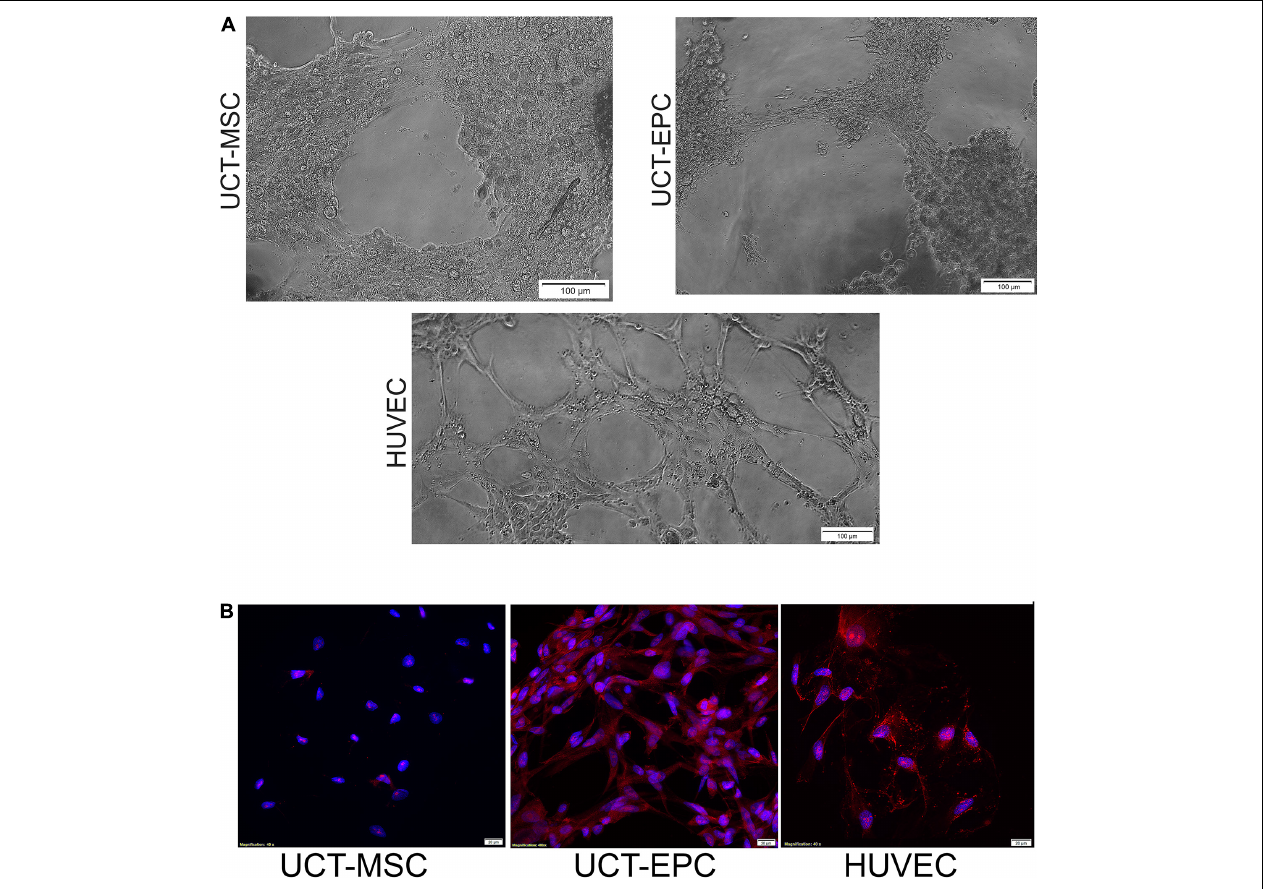
FIGURE 2 | (A) Functionality of UCT-MSC and UCT-EPC was determined by tube-forming assays and compared to HUVEC as a positive control. While quantification of number of branch sites/nodes demonstrated UCT-EPC tube-formation was not as robust as that of HUVEC, UCT-MSC did not form any tube structures. Cells initiated tubule formation at 4 h of culture, which fully developed by 6 h, with the presence of nodes of ≥ 4 branches; images were acquired on a Ziess Axiovert 200M and 10 × magnification. (B) Immunostaining of UCT-MSC and UCT-EPC in culture, demonstrated that the latter were positive for CD31. Images were acquired on a Ziess Axiovert 200M and 40 ×